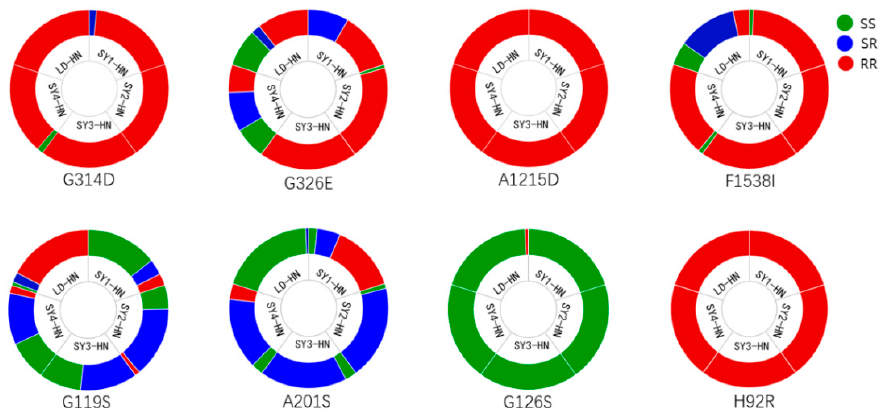
Figure 1. Mutation frequency of resistance genes in five T. urticae field populations in Hainan. G314D (GluCl1) and G326E (GluCl3) mutations, G119S and A201S mutations (Ace), A1215D and F1538I mutations (VGSC), G126S mutation (Cytb), and H92R mutation (PSST) in T. urticae are presented. SS, RS, and RR indicate homozygous susceptible, heterozygous, and homozygous resistant, respectively.